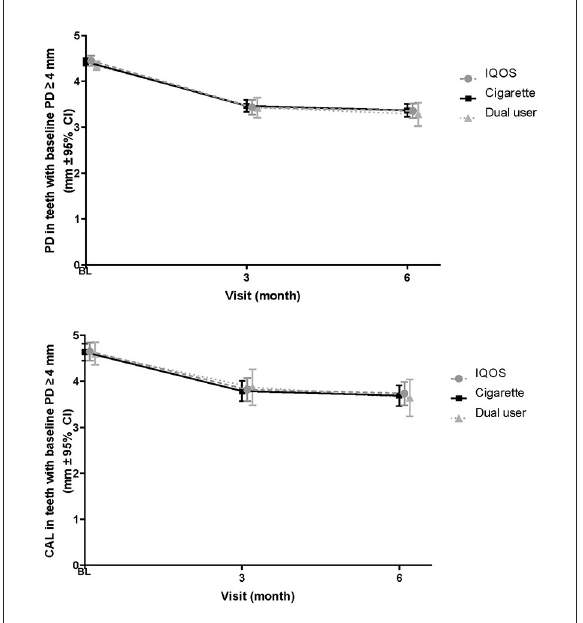
FIGURE2 Changes in PD and CAL in sites with initial probing depth ≥ 4 mm—As Exposed Set. BL, baseline; PD, probing depth; CAL, Clinical attachment level; CI, confidence